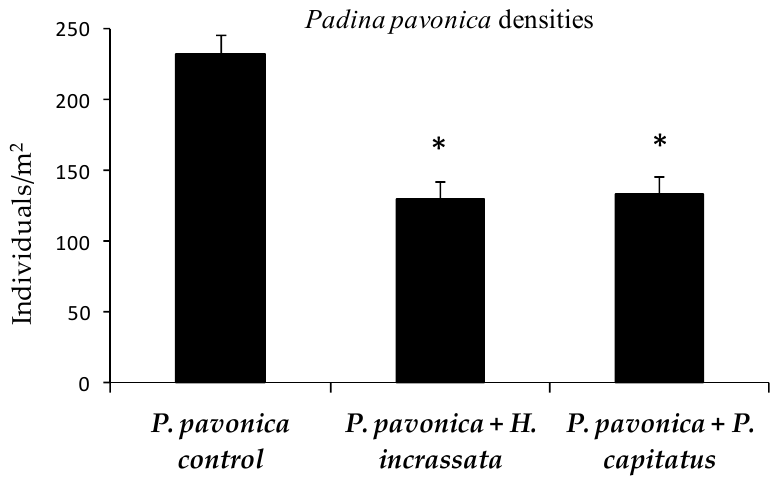
Figure 2. Density of Padina pavonica (Individuals/m 2 ) in the three studied areas in absence and presence of the invasive species. * Indicates significant differences in P. pavonica densities compared to control (one-way ANOVA). Values are expressed as mean ± S.E.M.